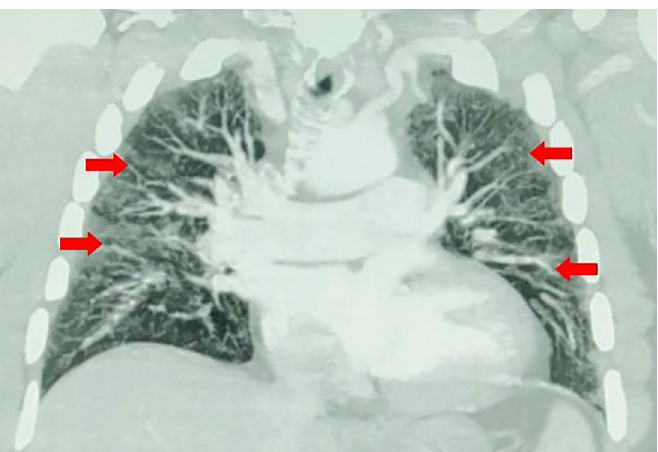
Image 2. Computed tomography angiography of the chest with intravenous contrast in the coronal view demonstrates no pulmonary embolism. However, there are moderate, scattered, diffuse pulmonary ground-glass and interstitial lung markings. The red arrows indicate mild subcutaneous stranding and edema of the pleura.